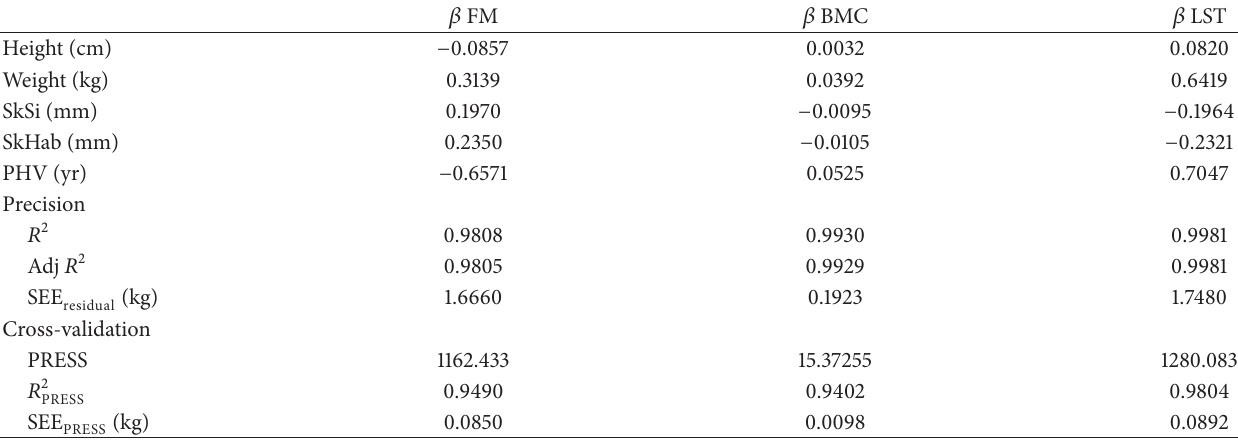
Table 3: Multicomponent anthropometric model matrix, precision, and internal cross-validity for simultaneously measuring of body composition in